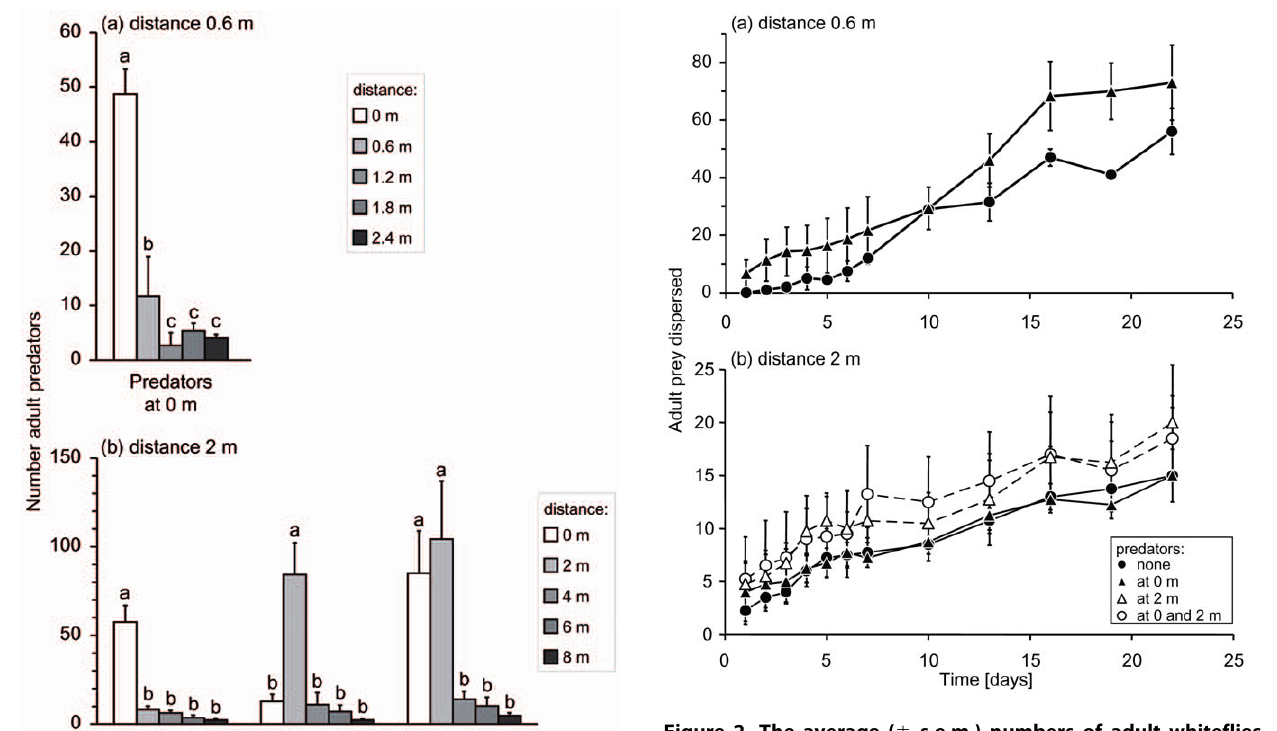
experiment with interplant distances of 0.6 m (Fig. 2a), this did not result in a higher number of adult whiteflies being found back on neighbouring plants at the end of the experiment. This shows that a temporal shift in the dispersal (Fig. 2a). The total number of adult whiteflies present on all plants at the end of the experiment (28 d) gives an indication of the effect of the predators on the prey populations. With an interplant distance of 0.6 m, whitefly populations were significantly lower in the presence of predators than in their absence (average 6 s.e.m.